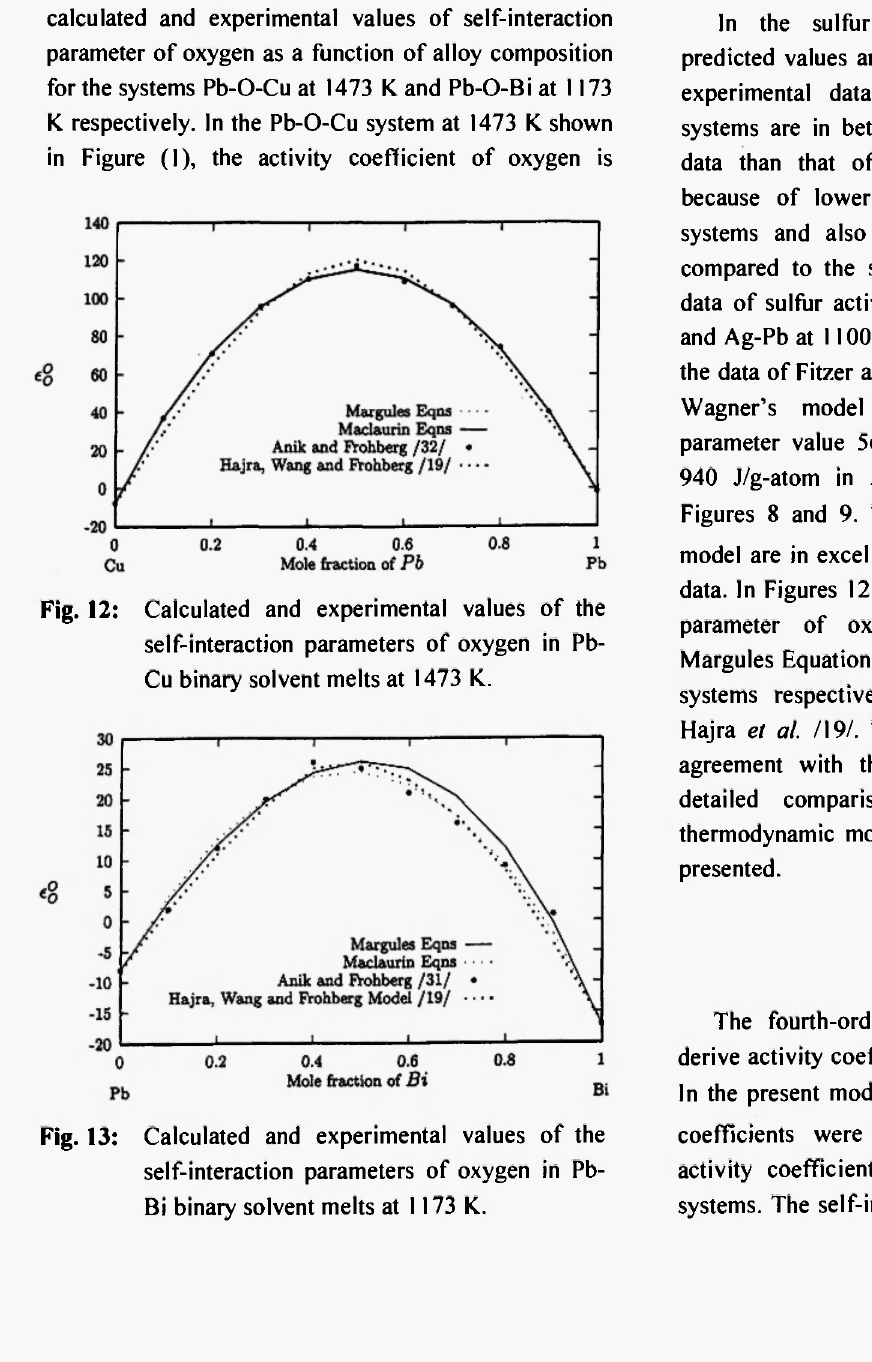
Fig. 13: Calculated and experimental values of the self-interaction parameters of oxygen in Pb- Bi binary solvent melts at 1173